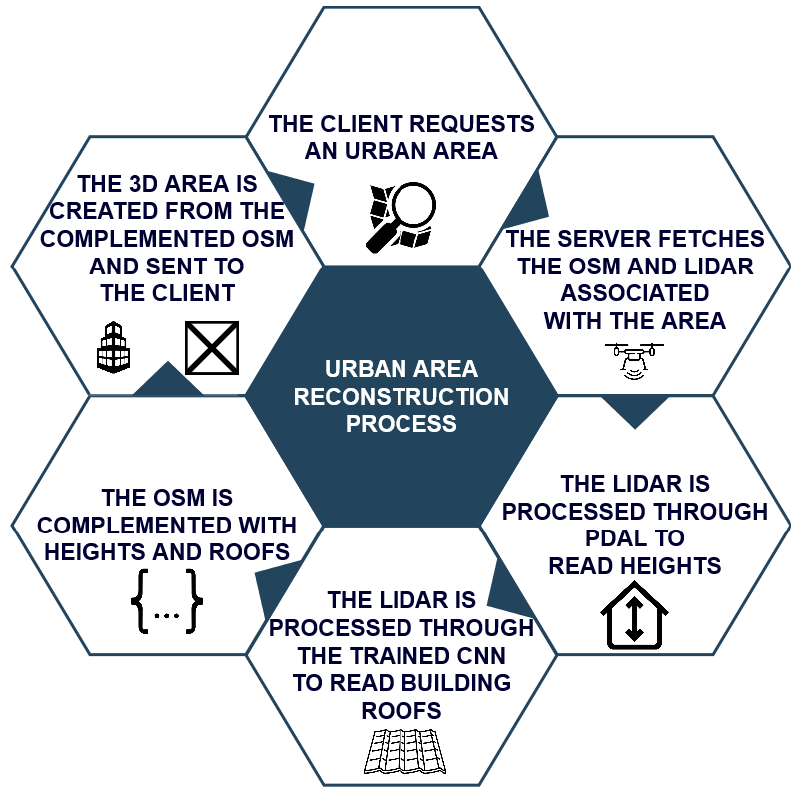
Figure 2. Diagram of the full process used to generate the 3D